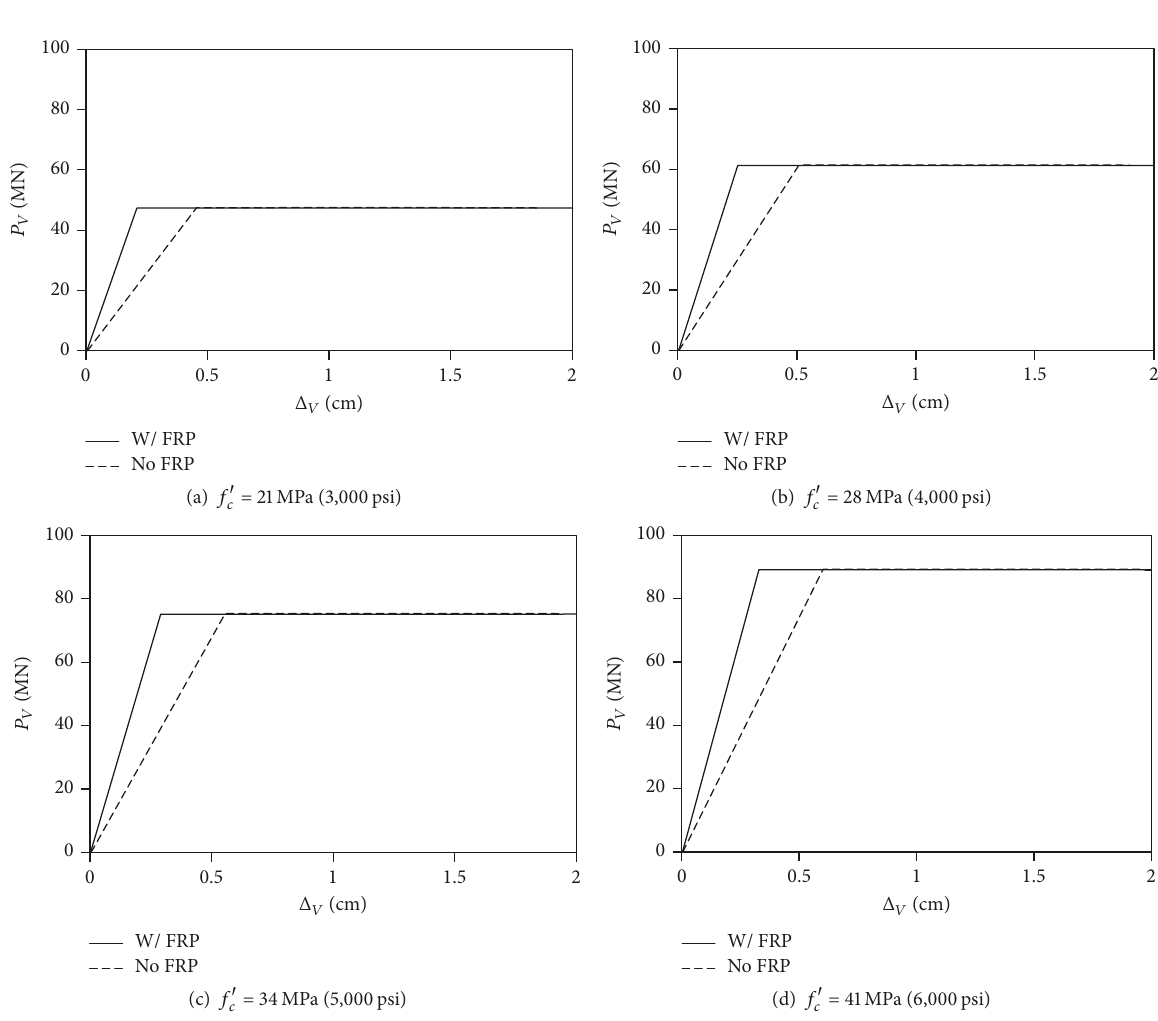
Figure 5: Pier section (1.2m by 1.2m) subjected to vertical loads (thickness of FRP wrap = 3.3